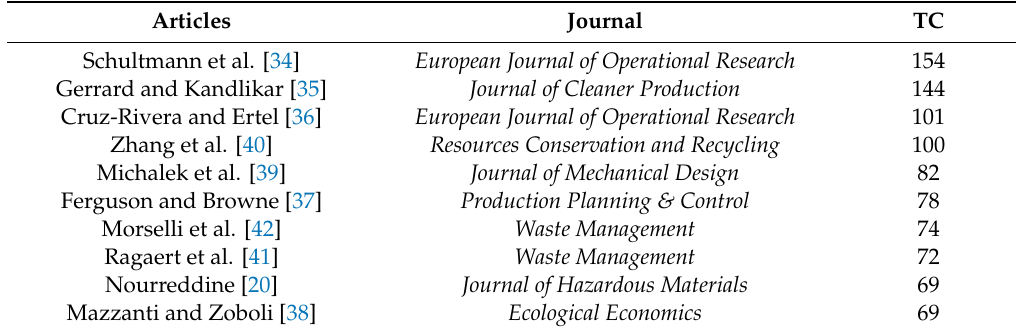
Table 5. The top 10 frequently cited articles between 2000 and